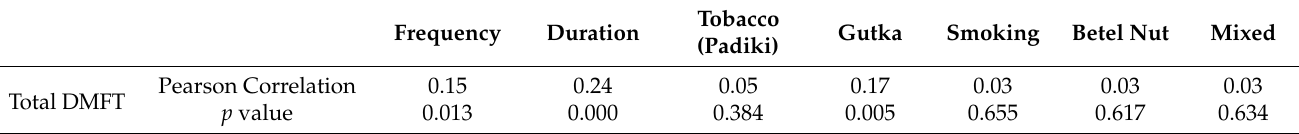
Table 5. Correlation analysis of DMFT and tobacco substance abuse. Frequency Duration